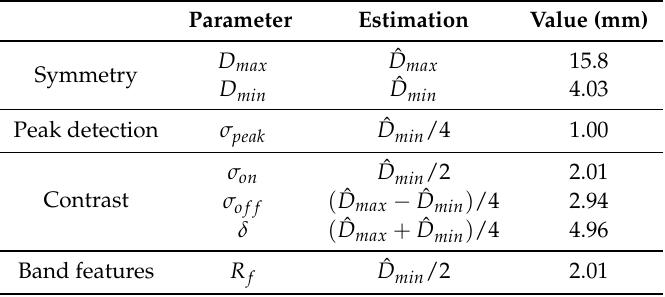
Table 1. Summary of the parameter estimation expressions and the resulting